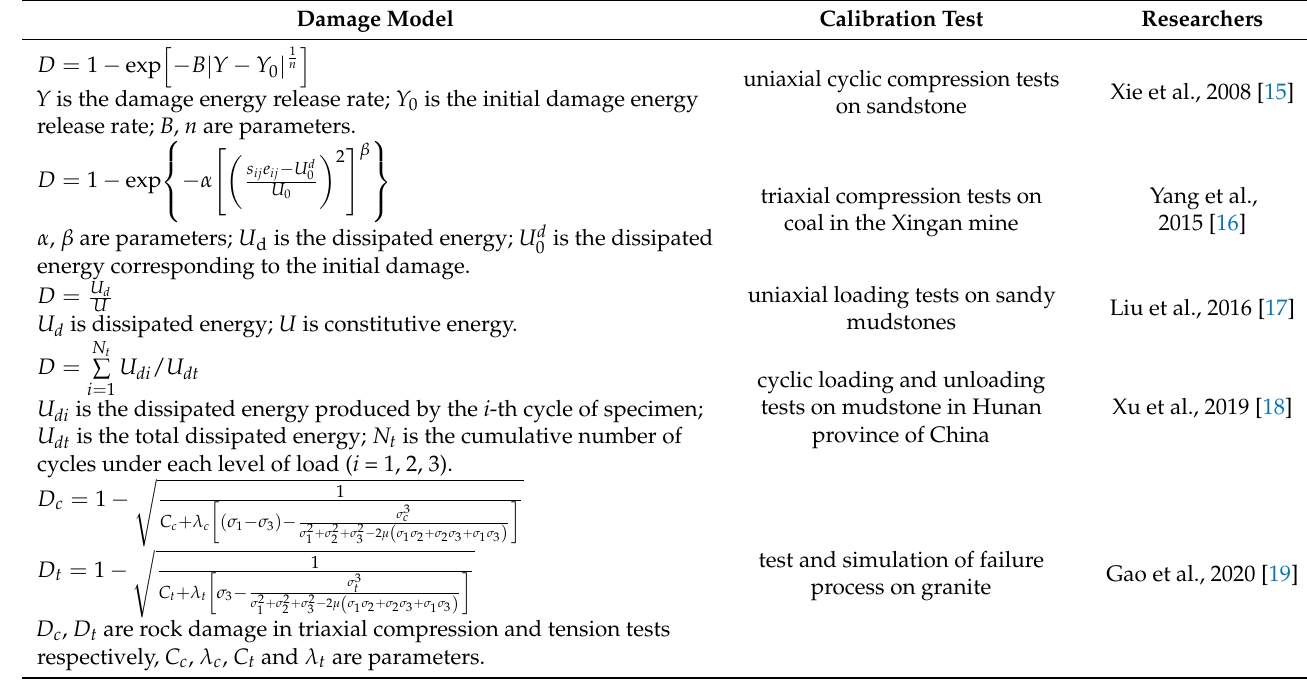
Table 1. Various damage models for